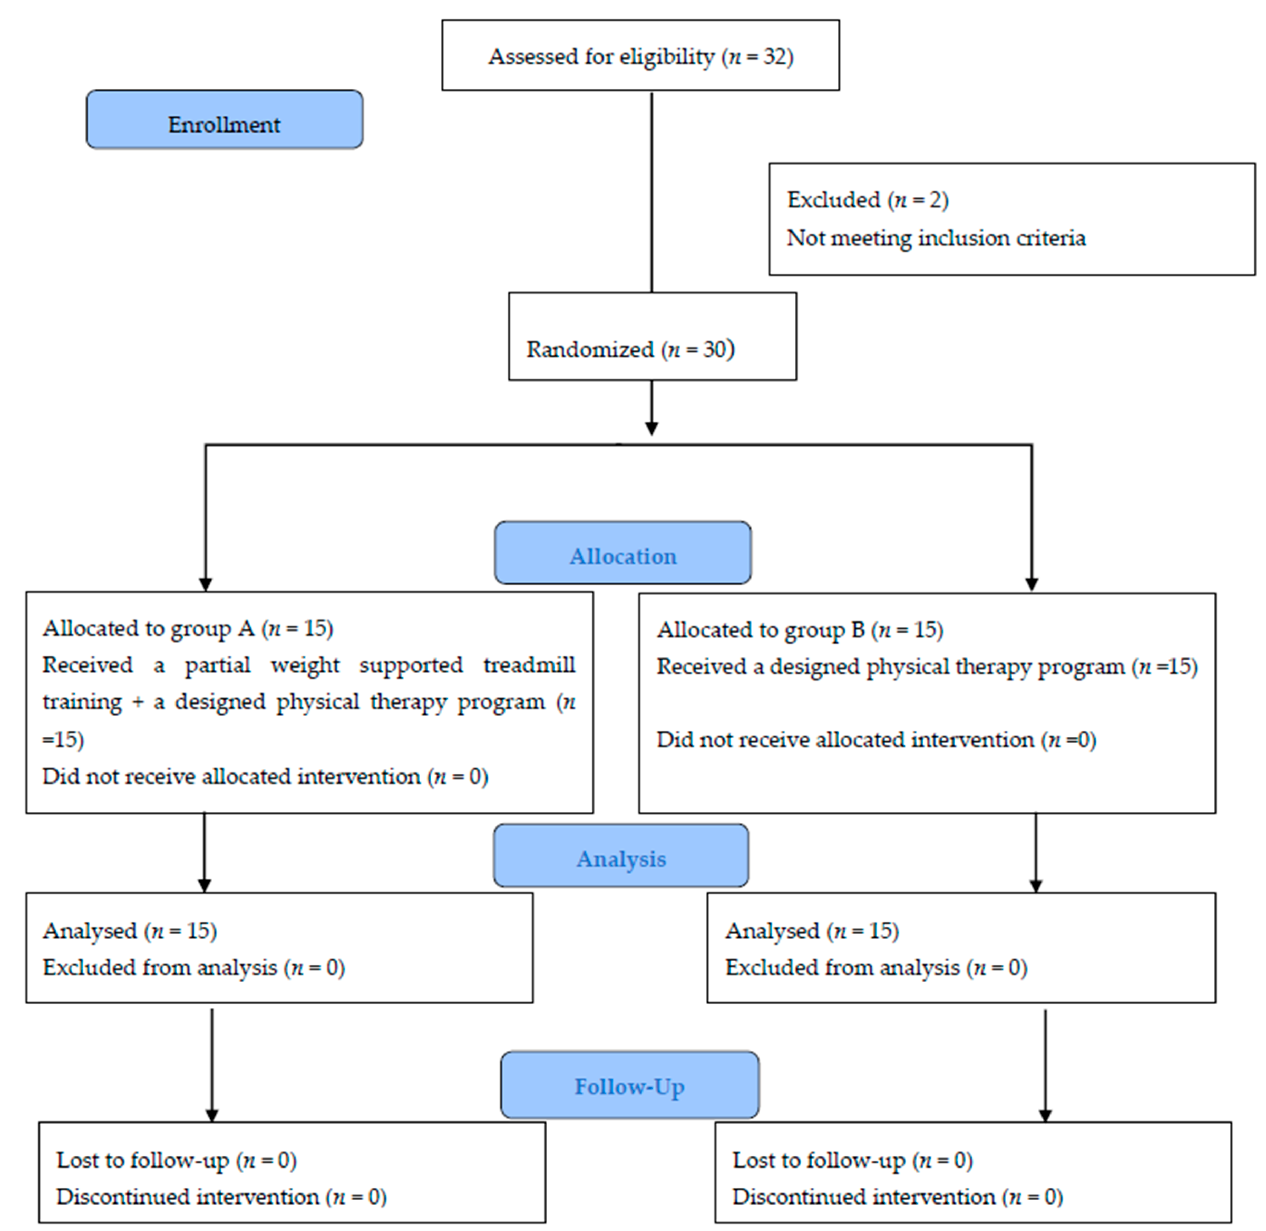
Figure 1. Flow chart of the study